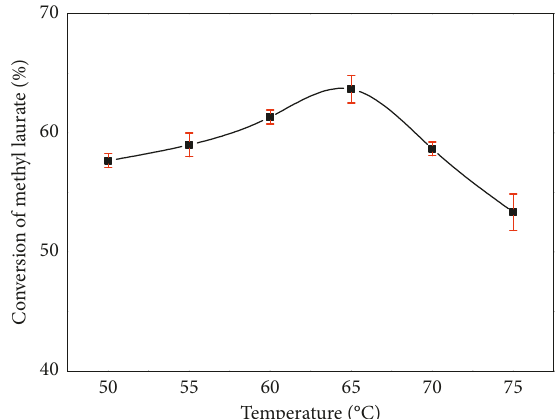
Figure 3: Effect of temperature on lipase-catalyzed trans- esterification of decylglycerol with methyl